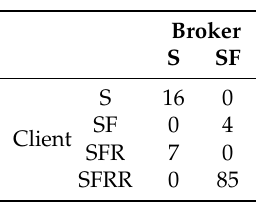
Table 8. TCP flags analysis.